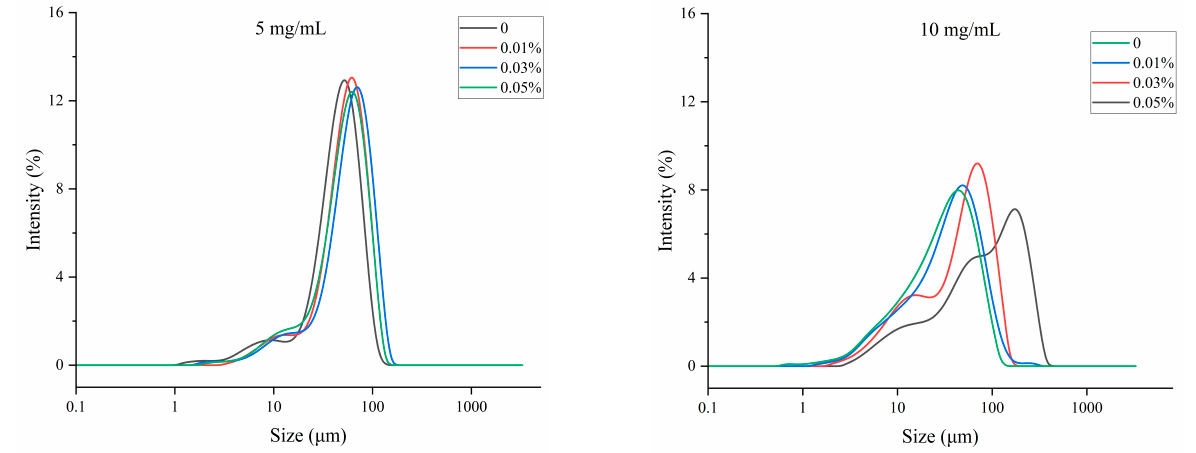
Figure 1. The droplet size distribution of MP O/W emulsion with different concentrations of TPP. Table 1. Effects of TPP on droplet size (d 3,2 ) of MP O/W emulsions. d 3,2 ( µ